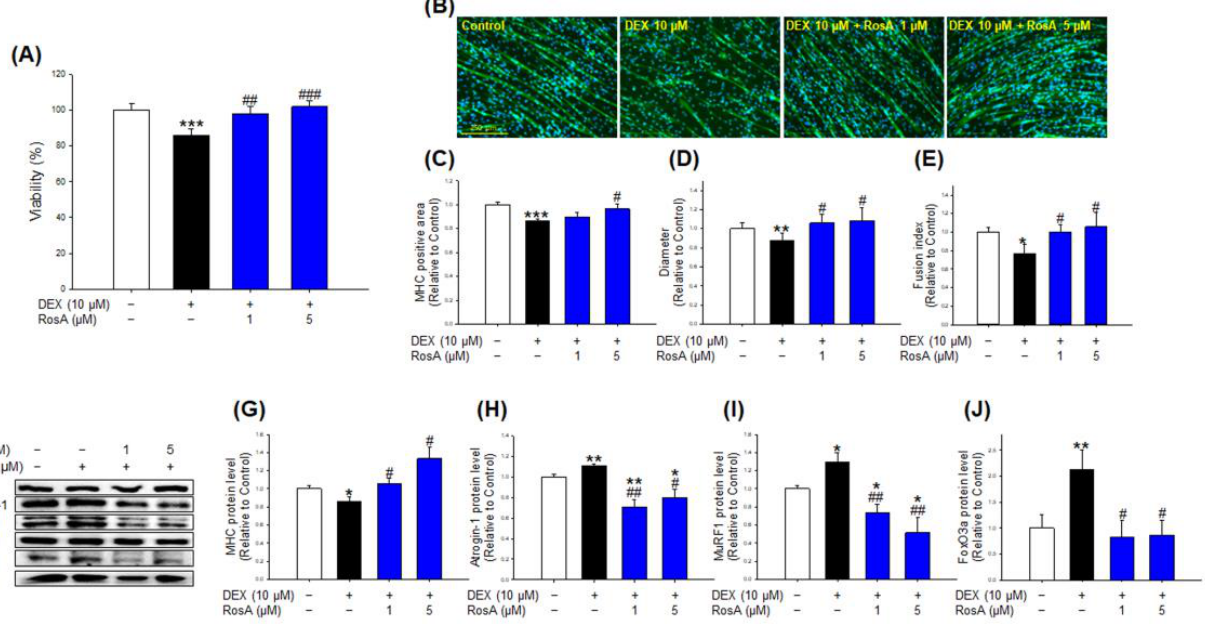
Figure 2. Effect of RosA on viability, morphology, and expression of muscle atrophy-related proteins in the DEX-stimulated C2C12 myotubes. ( A ) C2C12 myotubes were treated with DEX (10 µ M) in the presence or absence of RosA (1 and 5 µ M) for 24 h. ( B ) C2C12 myotubes were stained with MHC (green) and DAPI (blue), and representative photographs were observed under a fluorescent microscope (scale bar = 250 µ m). ( C ) Relative change in the MHC-stained area in myotubes, ( D ) diameters, and ( E ) fusion index were measured from randomly selected fields and quantified using the Image J program. ( F ) Expressions of MHC, Atrogin-1, MuRF1, FoxO3a, and GPADH were analyzed in C2C12 myotubes by western blotting. GAPDH was used as the loading control. ( G ) Quantitative analysis of MHC, ( H ) Atrogin-1, ( I ) MuRF1, and ( J ) FoxO3a. These results are presented as the means ± SD of three independent experiments: * p < 0.05, ** p < 0.01, *** p < 0.001 vs. control; # p < 0.05, ## p < 0.01, ### p < 0.001 vs. DEX.